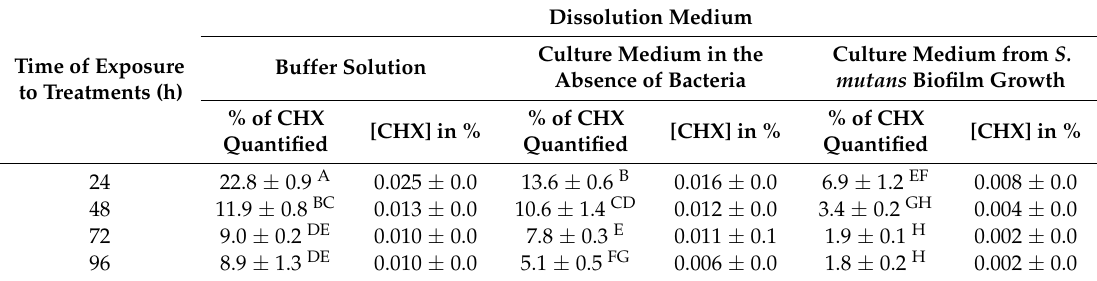
Table 2. Percentage of chlorhexidine (CHX) quantified and the final CHX concentration (in percentage) in the buffer, culture medium in the absence of bacteria and the culture medium from S. mutans biofilm growth at 24, 48, 72 and 96 h.